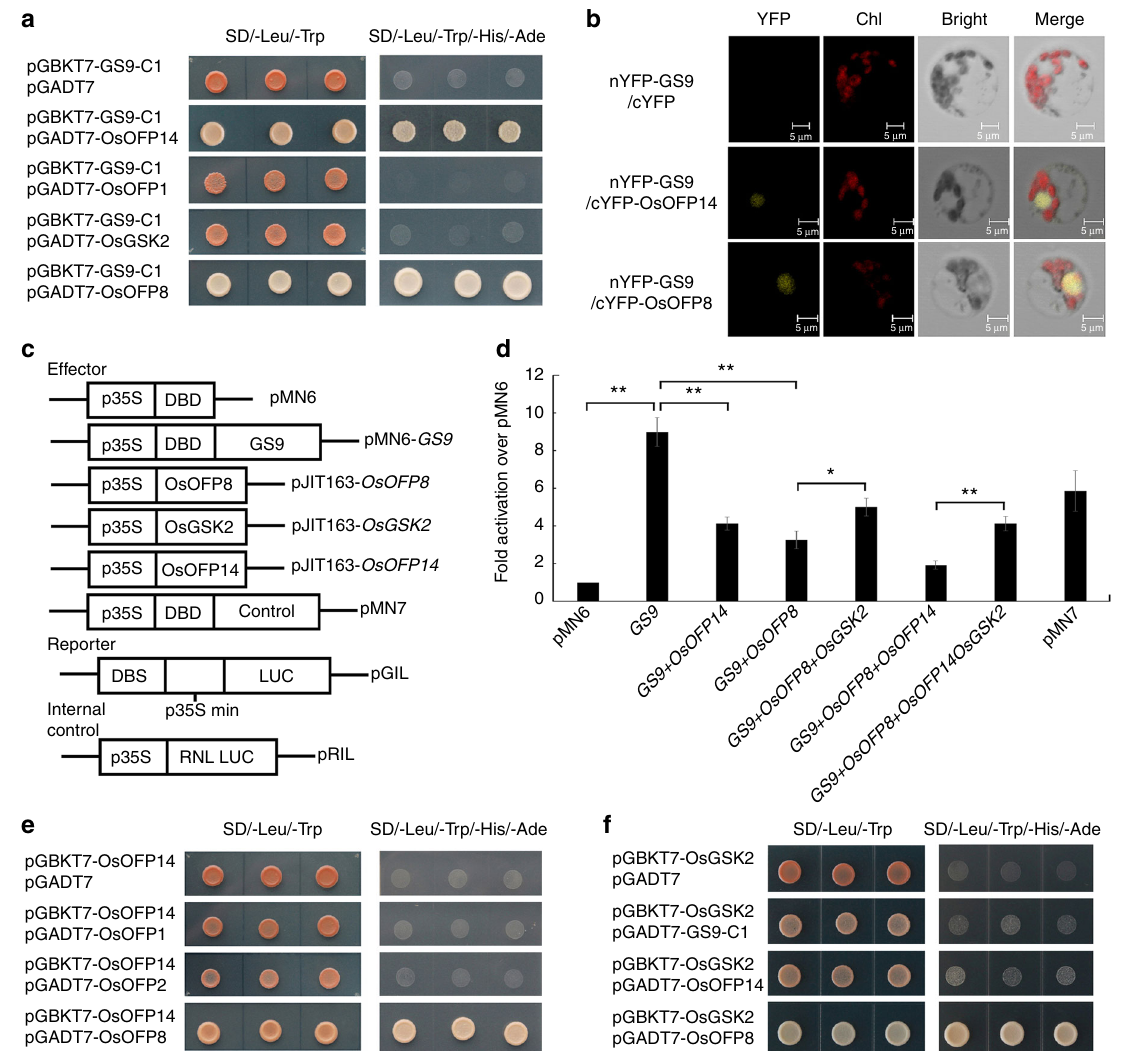
Fig. 5 OsOFP14 interacts with GS9 and decreases its transcription activity. a Analyses of interactions between GS9 and OsOFP14, OsOFP1, OsOFP8, OsGSK2 in yeast two-hybrid assay, respectively. GS9-C1 means the vector containing the C1 terminal of GS9 as shown in Fig. 4d. OsOFP14, LOC_Os04g33870; OsOFP1, LOC_Os01g12690; OsOFP8, LOC_Os01g64430; OsGSK2, LOC_Os05g11730. b Con fi rmation of the interaction between GS9 and OsOFP14, OsOFP8 in rice protoplasts using BiFC assay. nYFP and cYFP, N-terminal and C-terminal of YFP, respectively. Chl chlorophyll. Scale bar, 50 μ m. c , d Transcription activity assay using the pMN6 system. The main structure of vectors is shown in c . LUC fi re fl y luciferase; RNL LUC renilla luciferase. d shows the transcription activity in Arabidopsis protoplasts by co-transformation of different effector vector(s) with the reporter plasmid pGIL and internal control pRIL. Data are given as means± SD, with three biological replicates. * or ** signi fi cant difference ( P < 0.05 or 0.01, t -test). e , f Analyses of interactions among OsOFP14, OsOFP8, OsOFP1, and OsGSK2 in yeast two-hybrid